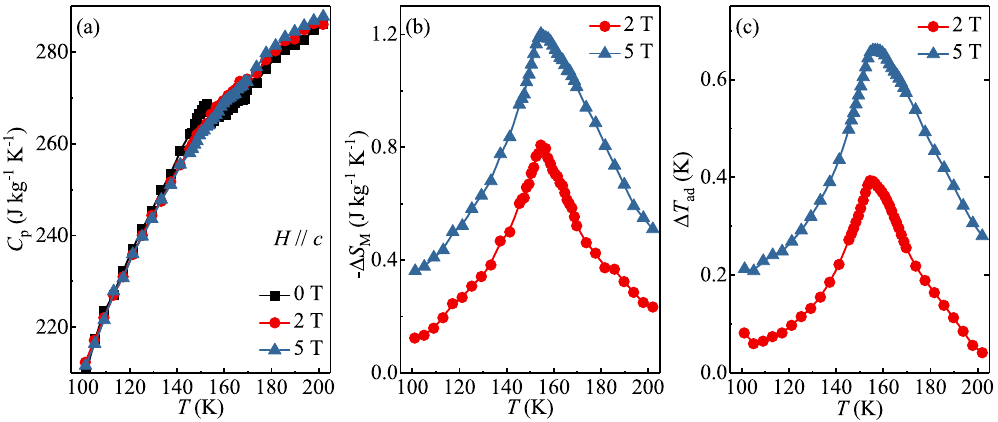
Figure 2. Temperature dependences of ( a ) the specific heat C p , ( b ) the magnetic entropy change −Δ S M , and ( c ) the adiabatic temperature change Δ T ad for Fe 3 − x GeTe 2 with out-of-plane field changes of 2 and